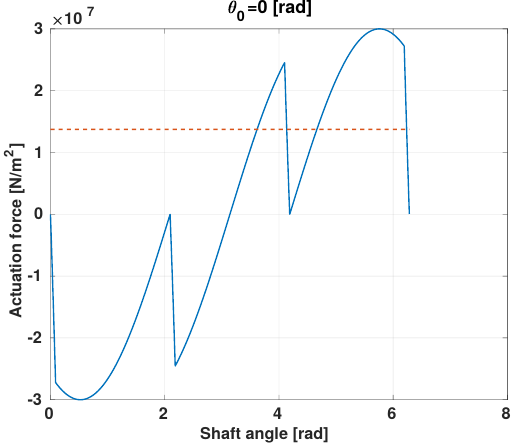
Figure 2: Equilibrium points when initial angle is 0